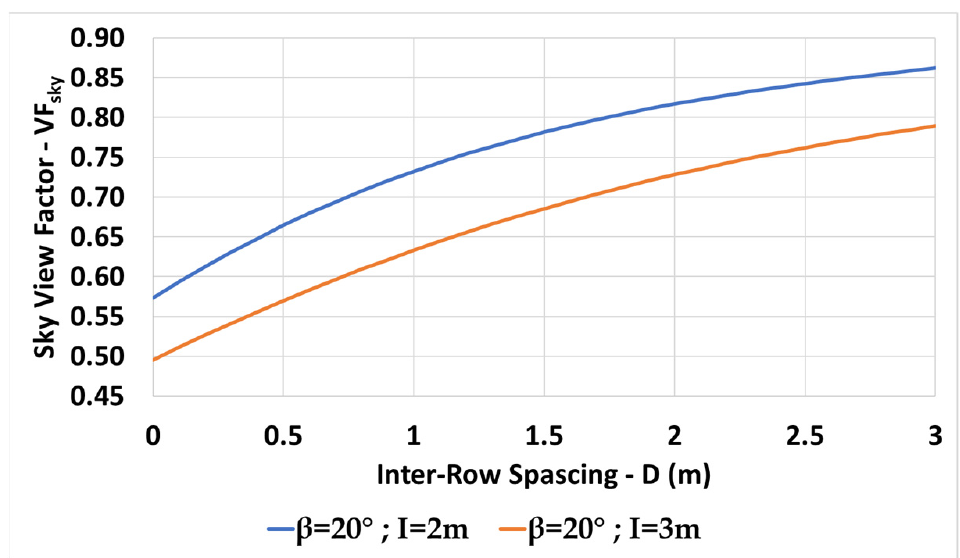
Figure 18. Variation of sky view of factor of a collector, on horizontal plane, with distance from a building of height, 𝐼 , collector in front a building.